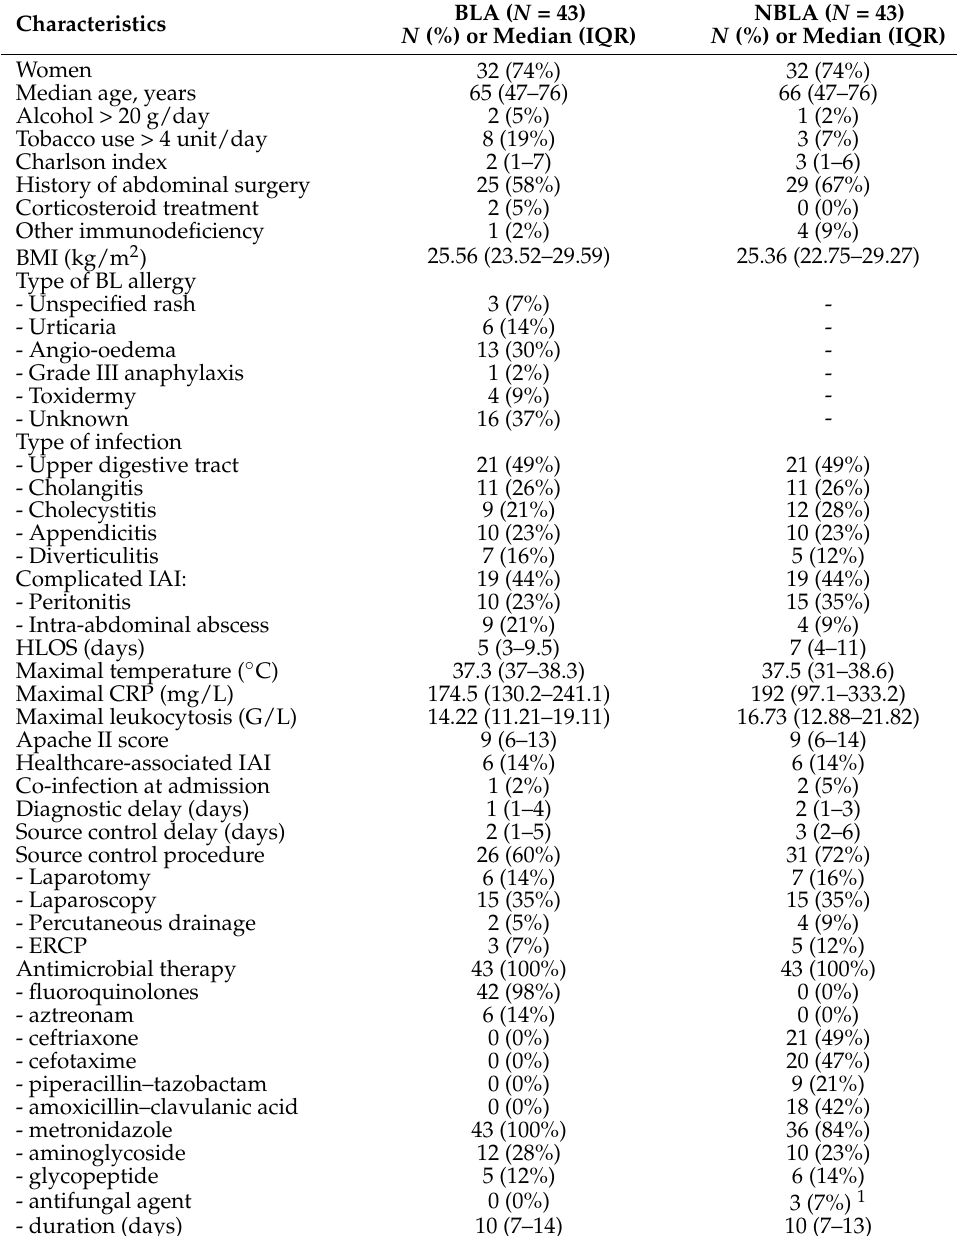
Table 1. Characteristics of the study